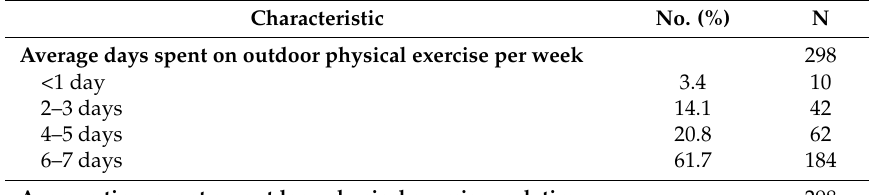
Table 2. Outdoor physical exercise patterns of the study population. Characteristic